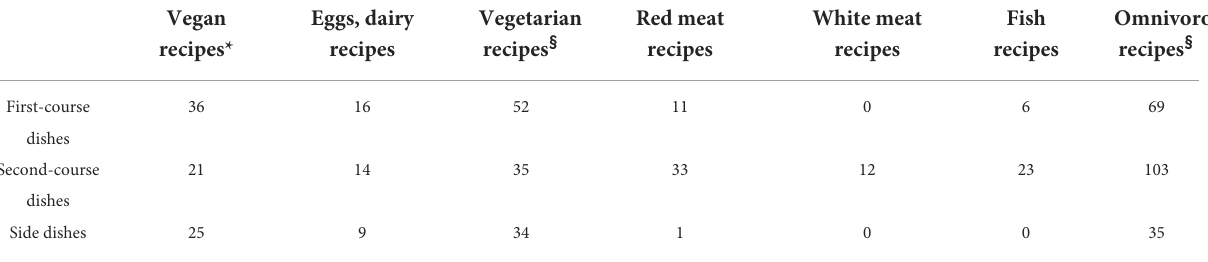
TABLE 1 Number of first-course, second-course, and side dishes divided according to the ingredients food group.